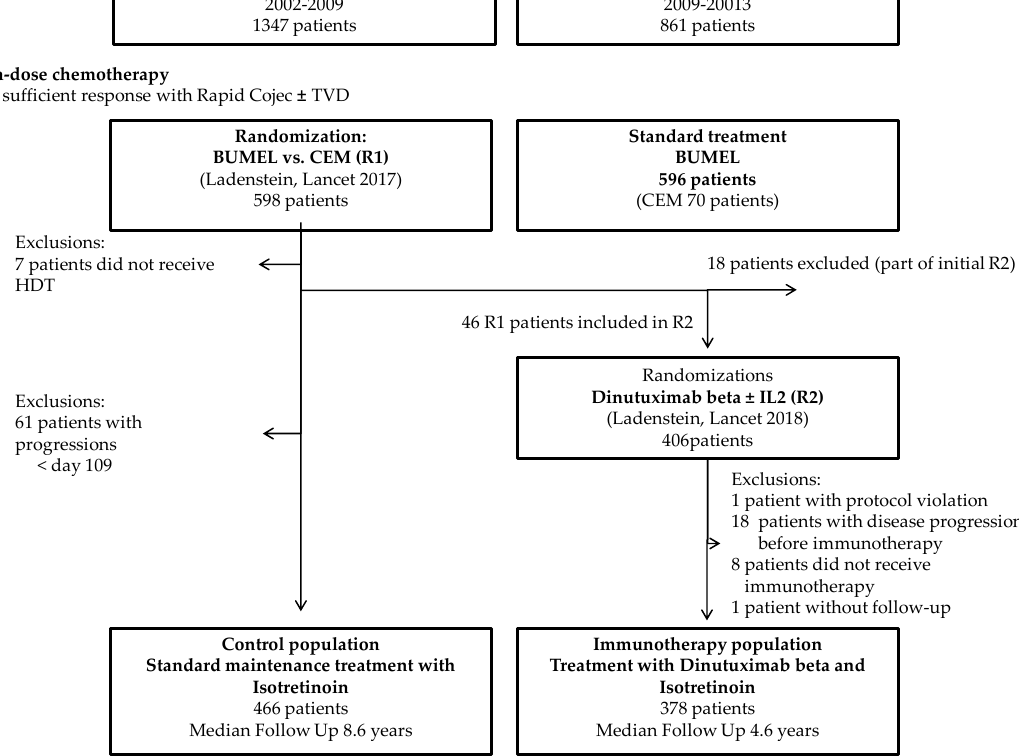
Figure 1. Flow chart for the analysis cohort. HDT (high-dose chemotherapy); BuMel (high-dose chemotherapy with busulfan and melphalan; CEM (high-dose chemotherapy with carboplatin, etoposide and melphalan); R1 (high-dose chemotherapy randomisation); R2 (immunotherapy randomisation) and IL-2 (interleukin-2).